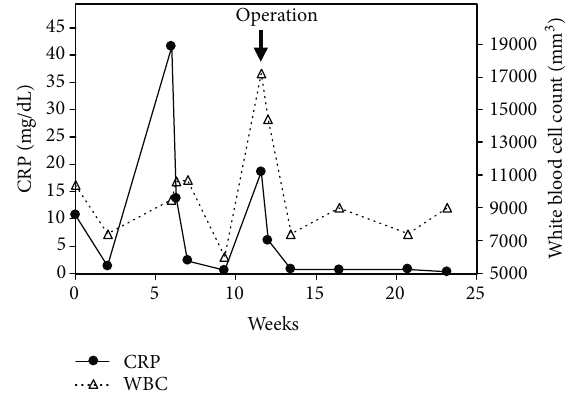
Figure 4: Time course of laboratory data of white blood cell count and C-reactive protein concentration. Arrow indicates the timing of surgical